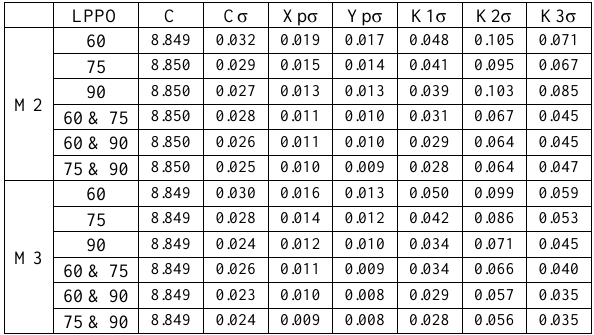
Table 7. Sigma statistics for proposed aerial missions when comparing flying heights(ft).